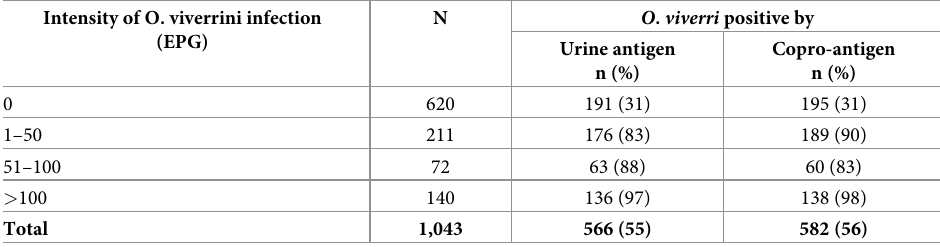
Table 2. Positive rates of O . viverrini determined by urinary and copro-antigen detection in different groups of participants stratified by intensity of infection (EPG). Intensity of O. viverrini infection